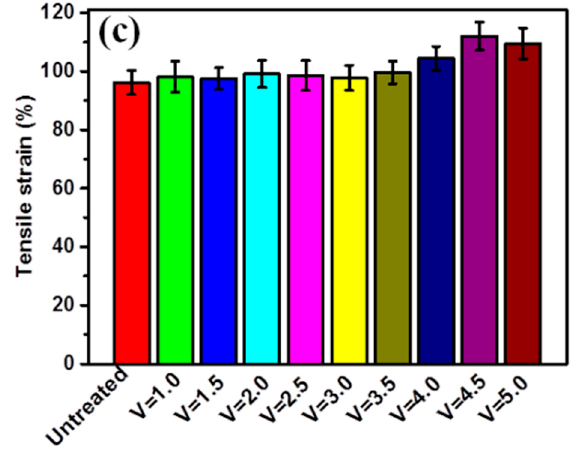
Figure 9. Tensile properties of braid-reinforced composite hollow fiber tubes with different coating speeds and uncoated stainless steel wires: ( a ) modulus of elasticity, ( b ) tensile strength, ( c ) tensile strain.